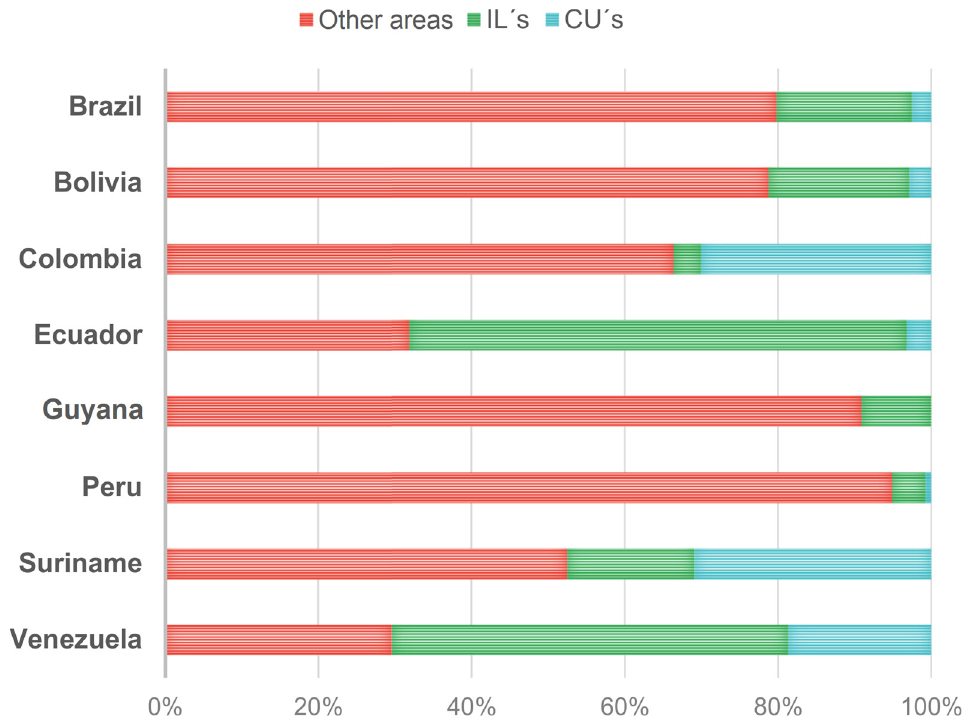
Figure 5. Percentage of burned area in conservation areas (indigenous lands (ILs) and conservation units (CUs)) and other areas in each country in the Amazon Basin. The burned area weighted values of each country by the total Amazon Basin area are listed in Tables S3 and S4.